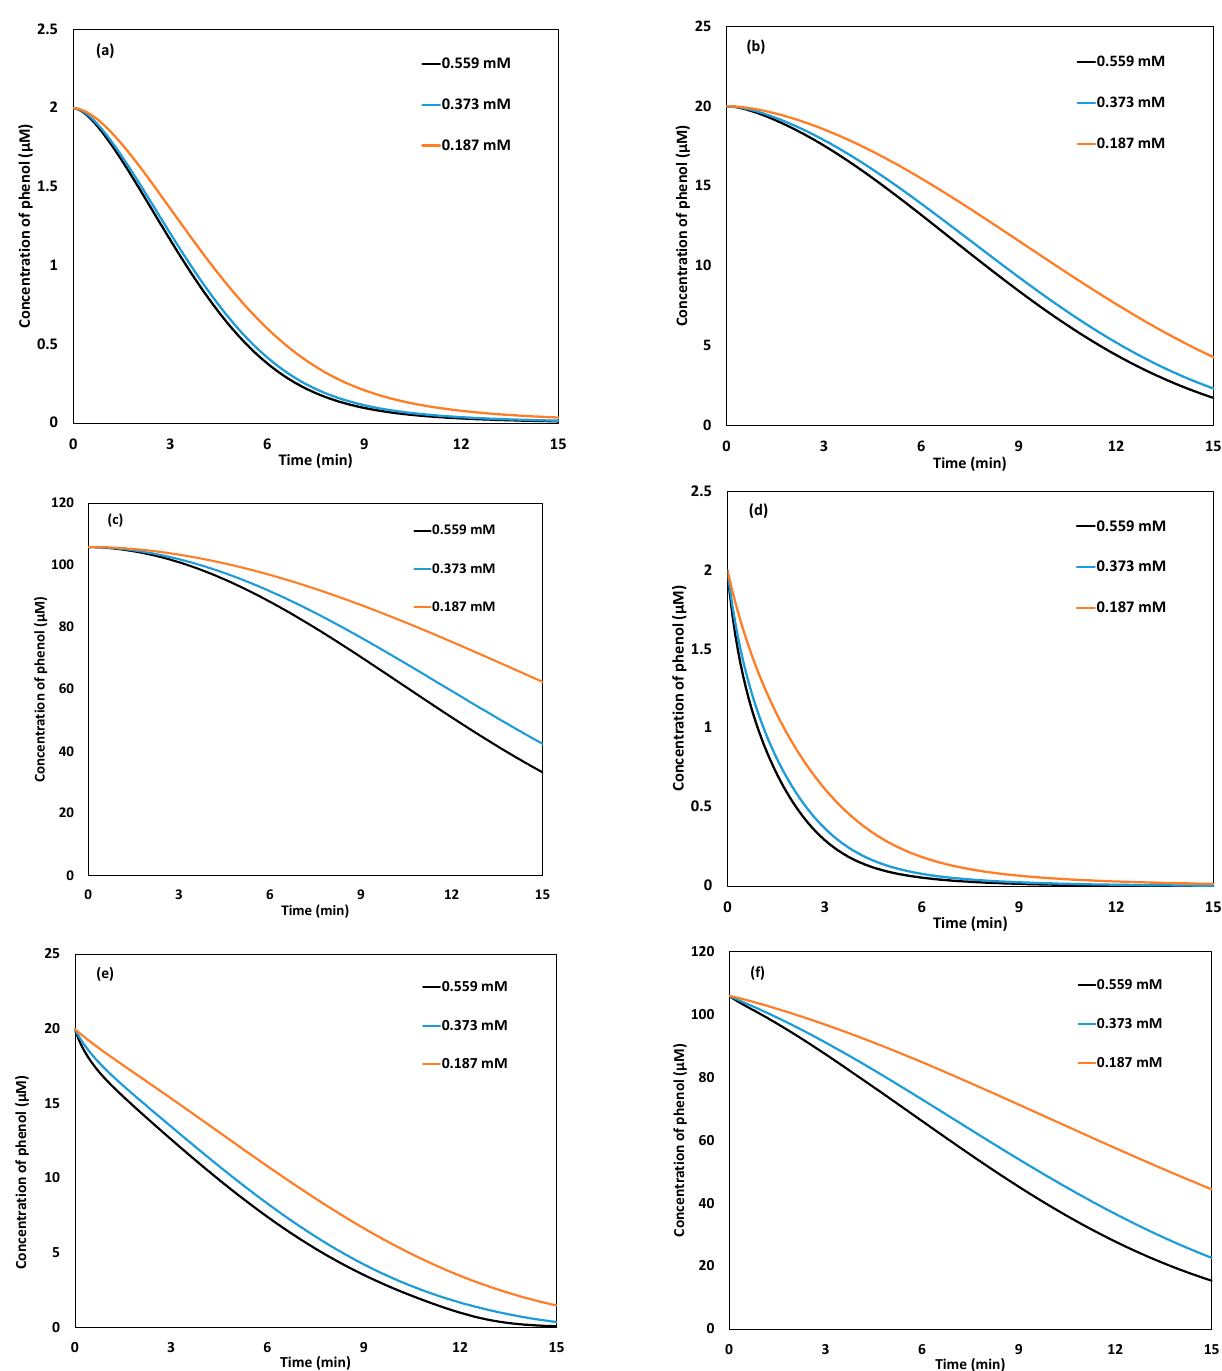
Figure 10. Degradation kinetics of phenol considering three different initial concentrations of phenol (2, 20 and 105.4 µM) and hydrogen peroxide (0.559, 0.373, and 0.187 mM) in the Galvano-Fenton process ( a – c ) and in the Galvano-Fenton process with pre-immersion time ( d – f ).